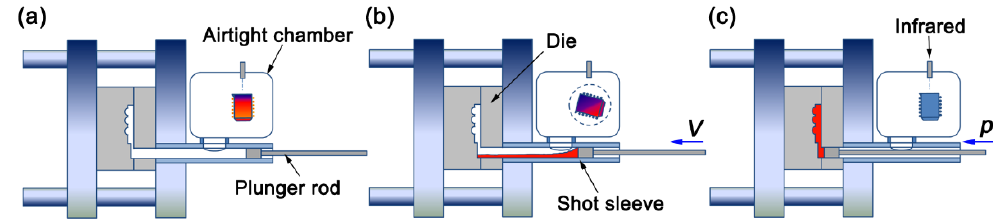
Figure 1. Illustration of the EPV-HPDC equipment and operating mode: ( a ) loading materials and melting, ( b ) pouring liquid metal into the shot sleeve and filling die, and ( c ) solidifying under pressure.